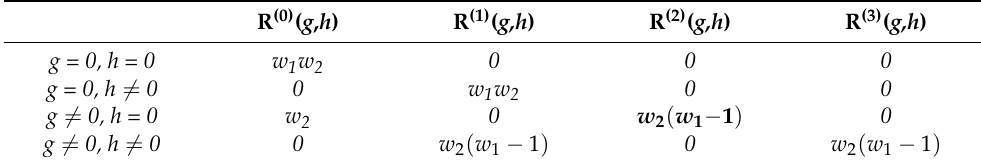
Table 3. Cross-correlation values of 2D-BIBD